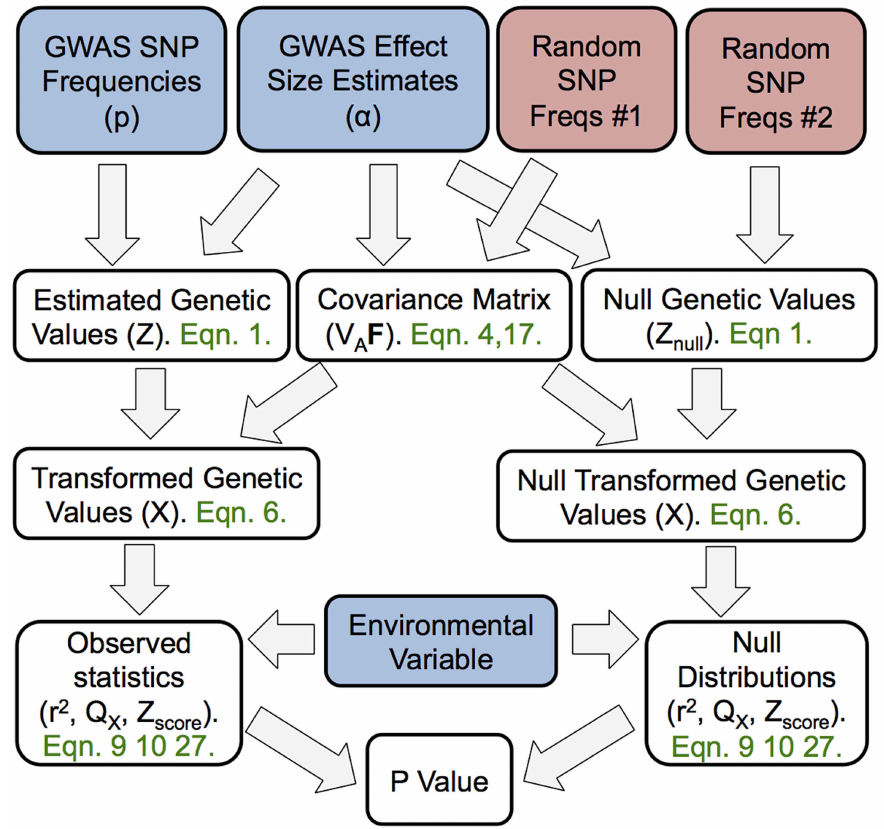
Figure 1. A schematic representation of the flow of our method. The boxes colored blue are items provided by the investigator (GWAS SNP effect sizes, the frequency of the GWAS SNPs across populations, and a environmental variable). The boxes colored red make use of random SNPs sampled to match the GWAS set as described in ‘‘Choosing null SNPs’’ in the methods section. For each box featuring a calculated quantity a set of equation numbers are provided for the relevant calculation. The Z score uses the untransformed genetic values, rather than the transformed genetic values, but this relationship is not depicted in the figure for the sake of readability.